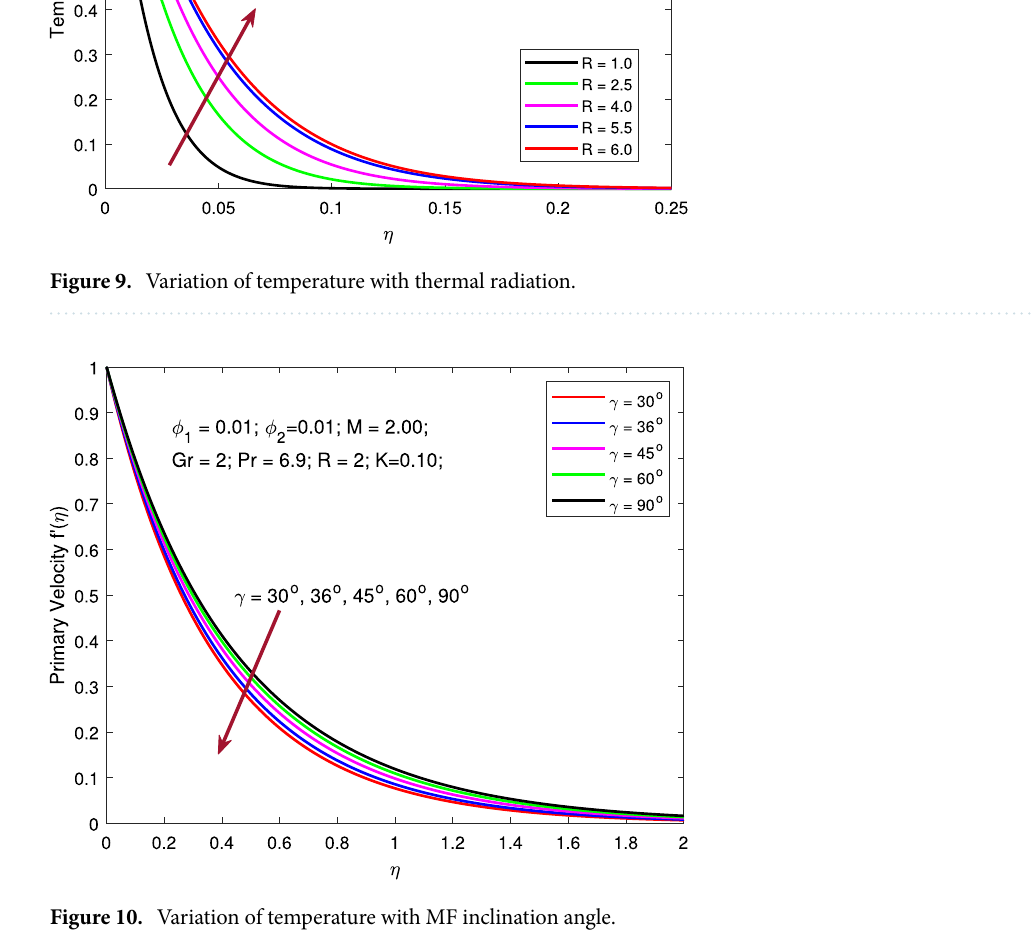
Figure 10. Variation of temperature with MF inclination